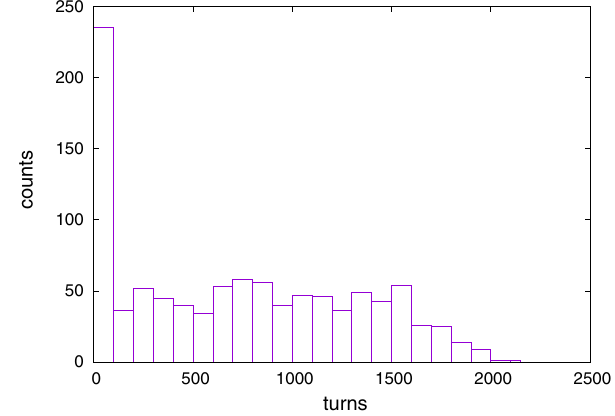
FIG. 7. Rate of particles kicked by the crystal achieving − 20 mm of displacement, or more, at the extraction point. The number of particles is shown on the vertical axis, while the number of turns after the first interaction with the crystal is shown on the horizontal axis. The initial tracked population is 10 3 particles and each turn corresponds to 0 . 1 μ s. Each bin corre- sponds to 100 turns.